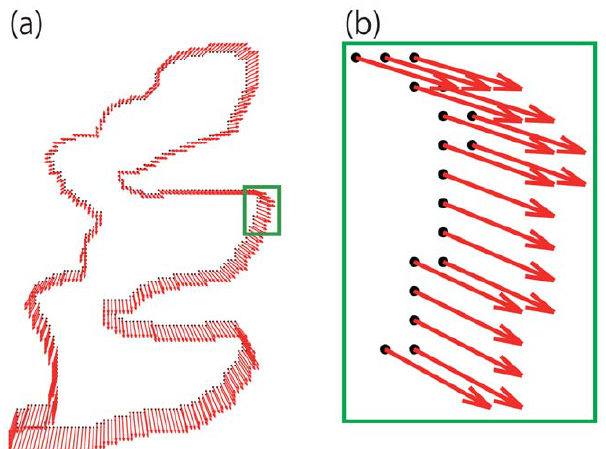
Figure 6. Results of loading condition optimization. (a) is Loading condition and (b) is Close up view of (a). The black points are boundary nodes, and the red arrows are loading condition vectors for each node. (b) is a close-up of (a) from the green area.